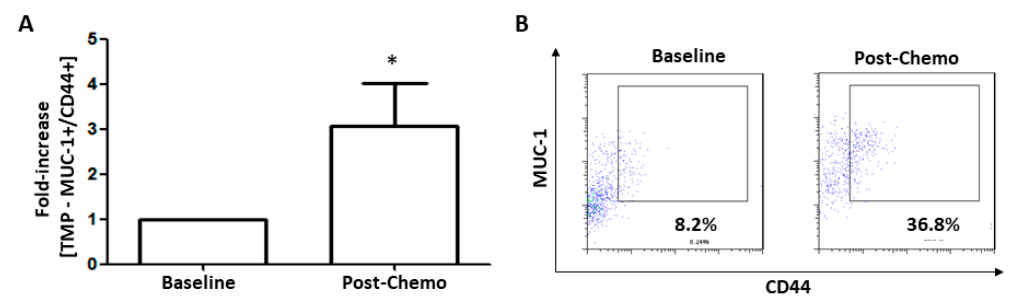
Figure 7. Elevated CD44 expression in peripheral TMPs from breast cancer patients who underwent chemotherapy . ( A , B ) Blood was collected from breast cancer patients at baseline, and 24 h after the first cycle of paclitaxel therapy ( n = 15). The percentage of TMPs (expressing both MUC-1 and CD44) was evaluated by flow cytometry in baseline and post-chemotherapy platelet-poor plasma samples. Fold-increase of TMPs (MUC-1 +/ CD44 + ) was calculated relative to baseline levels, and found to be statistically significant ( p < 0.05) using the non-parametrical Wilcoxon signed-rank test ( A ). Representative dot plots of the flow cytometry analysis are shown ( B ). * p <0.05.